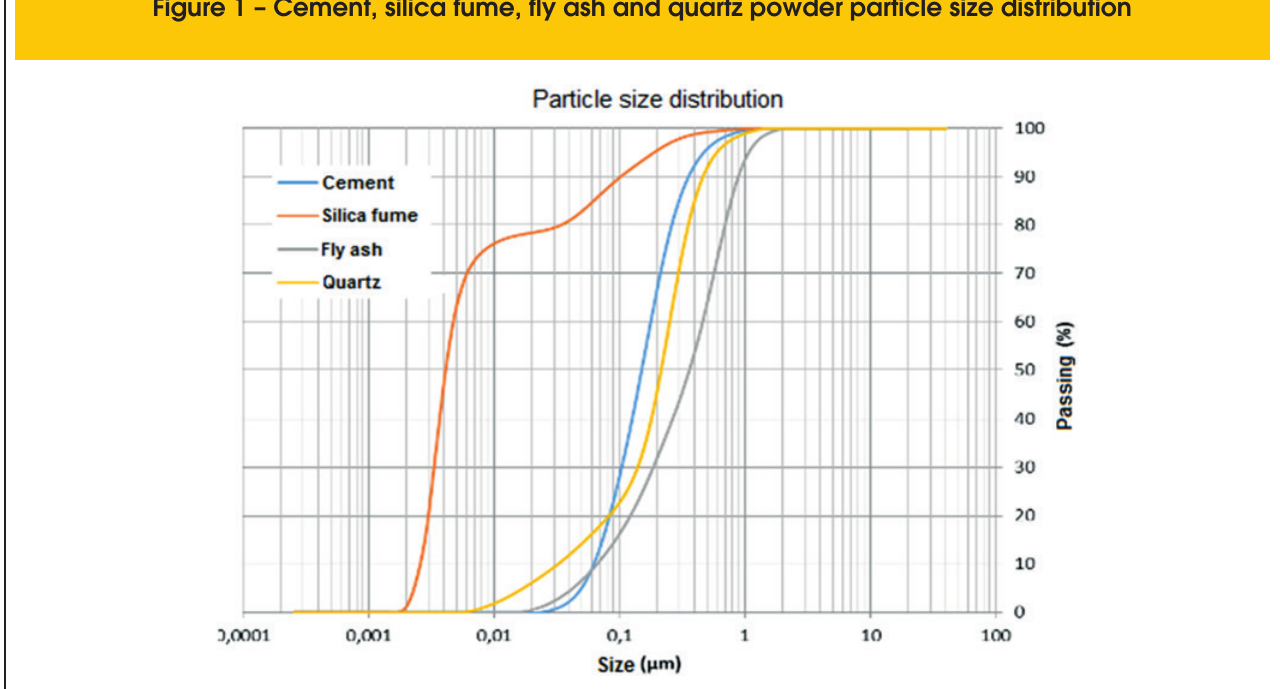
Figure 1 – Cement, silica fume, fly ash and quartz powder particle size